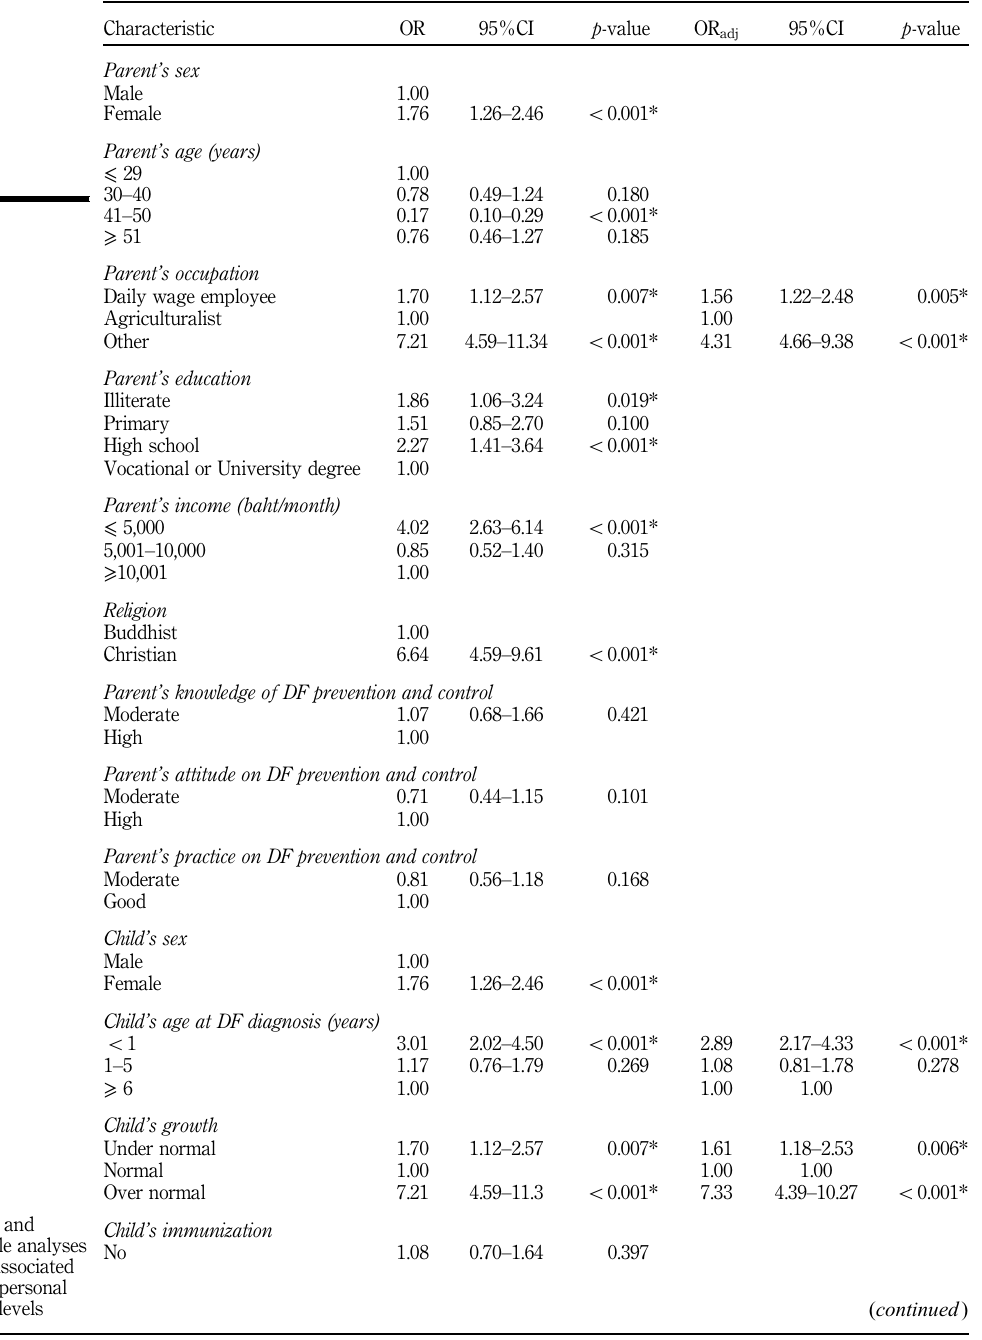
multivariable analyses on factors associated with DF at personal and family